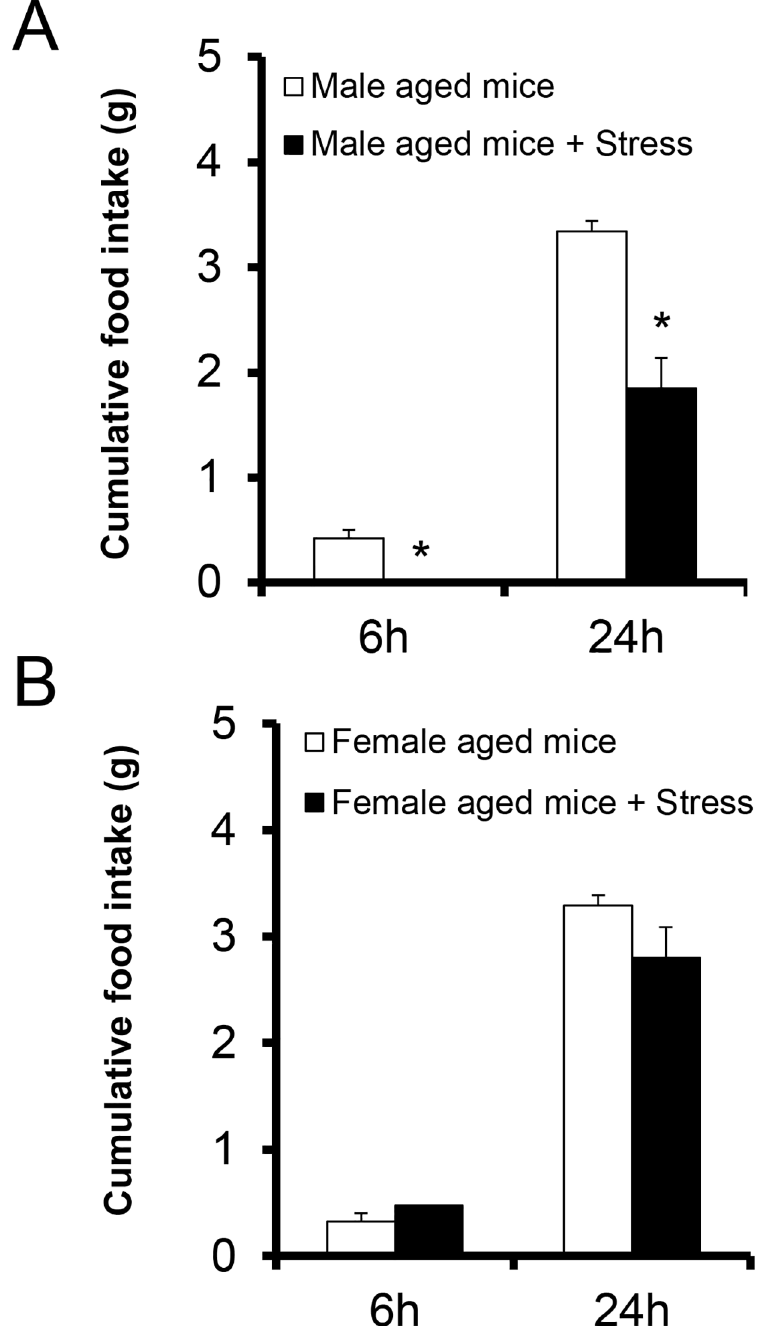
Fig 3. Changes in the cumulative food intake in aged male or female mice exposed to novelty stress. The cumulativefood intake in aged male mice (A) and female mice (B) exposedto novelty stress duringthe fed condition. Data are presentedas the mean ± SEM (n = 5). * , p < 0.05 vs. non-stressed group.